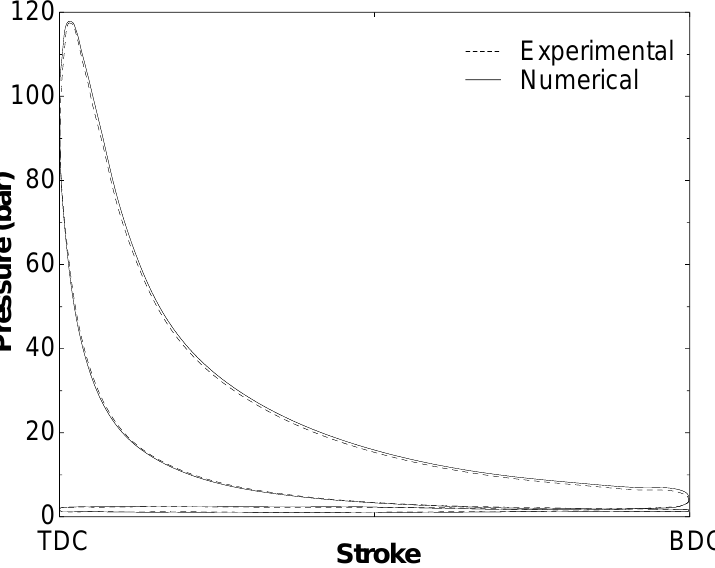
Figure 4. Pressure at 100% load experimentally and numerically measured. Operation under diesel combustion without ammonia.